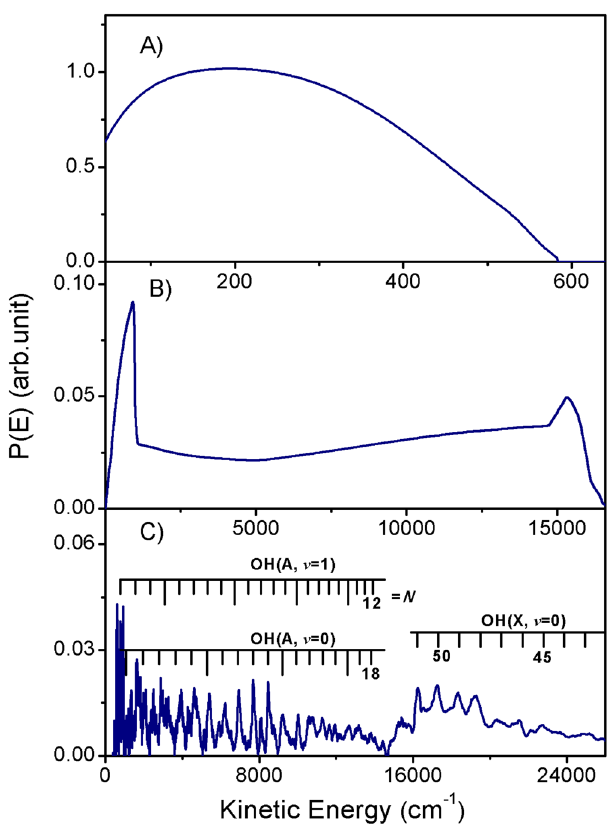
Fig. 2 The simulated kinetic energy release spectra from H 2 O photodissociation. TKER distributions determined from simulating the ( A ) O( 1 D) + 2H, ( B ) O( 3 P) + 2H, and ( C ) OH + H product yields from photodissociation of H 2 O at λ = 107.4 nm. The sharp features in the H + OH product yield have been assigned to population of ro-vibrational levels of the X and A states of the OH radical. Source data are provided as a Source Data fi le.